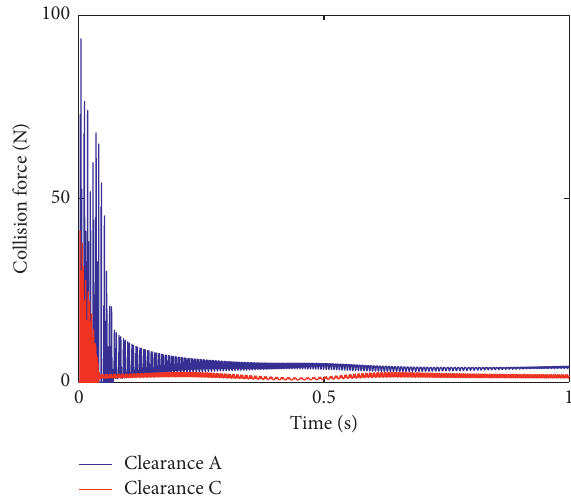
Figure 7: Collision force under different clearance positions.